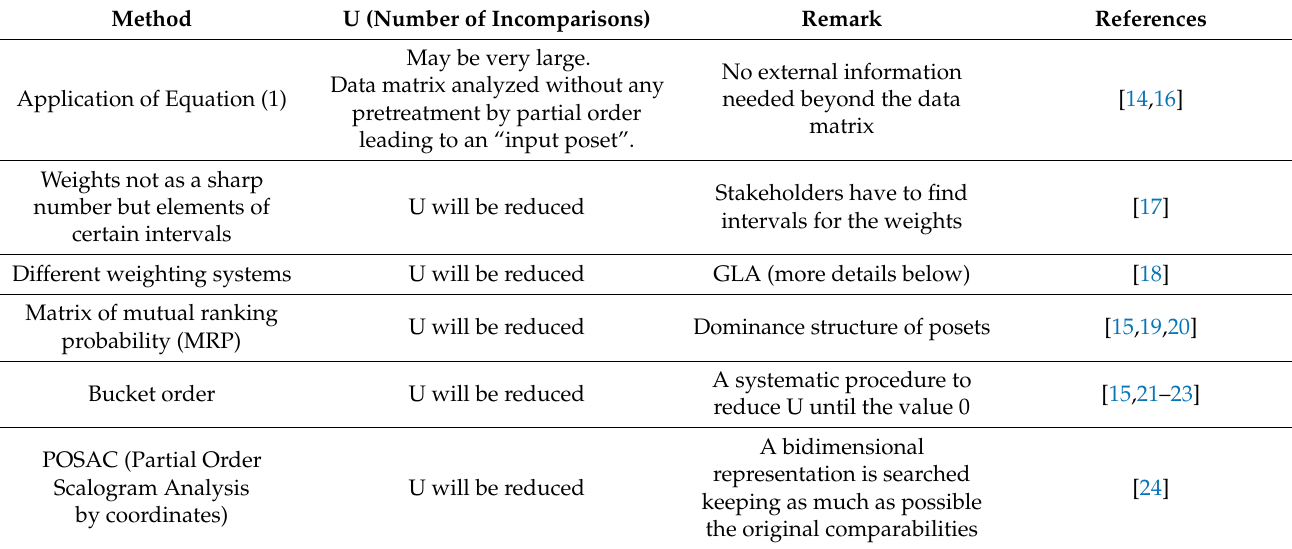
Table 1. Attempts to enhance the degree of